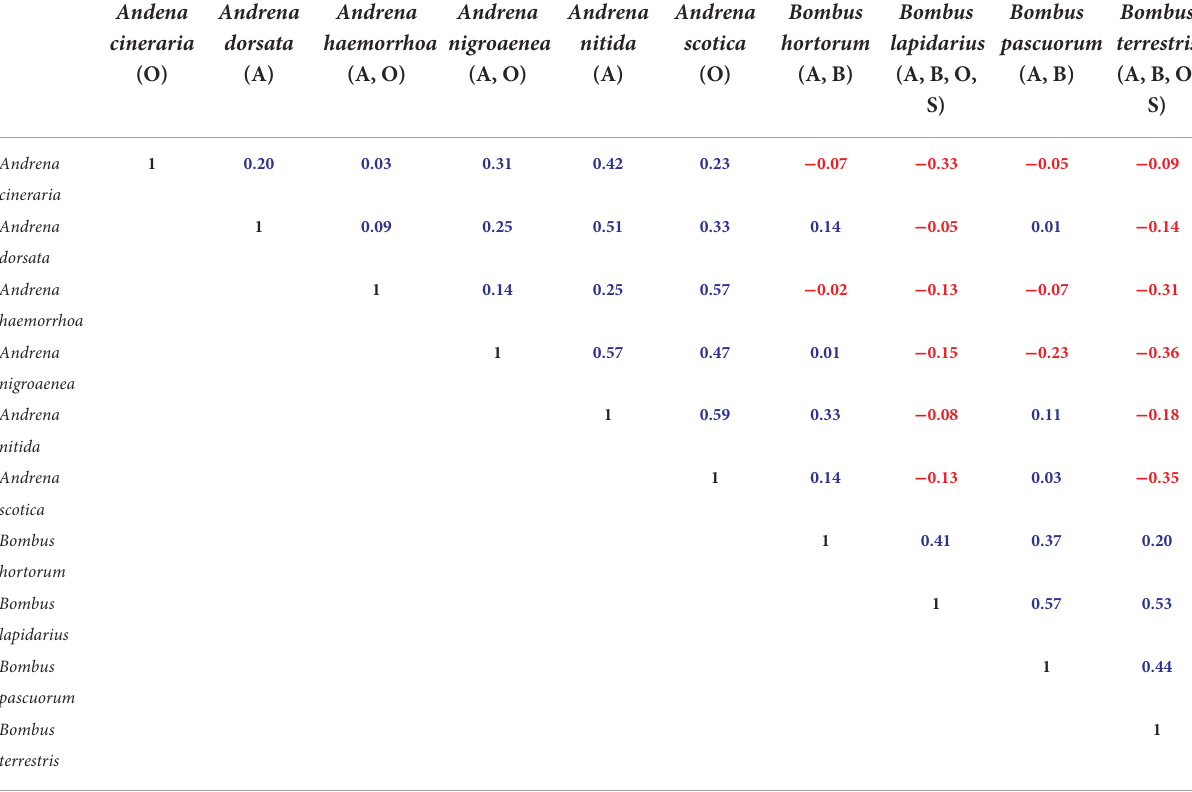
TABLE 1 Pearson’s r correlation scores of inter-annual occupancy estimates for bee species pairs identified as primary pollinators of apple (A), field beans (B), oilseed rape (O) and strawberry (S) crops (positive scores highlighted in blue and negative scores highlighted in red).